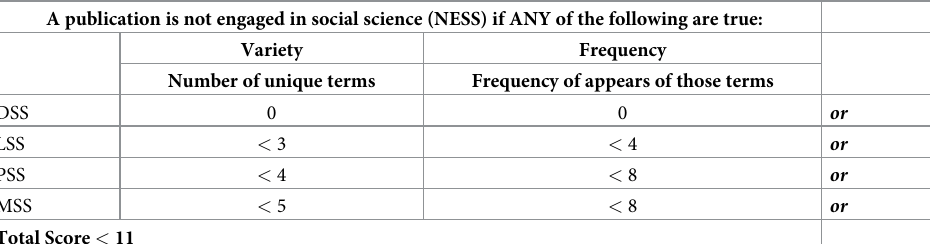
Table 5. Stepwise